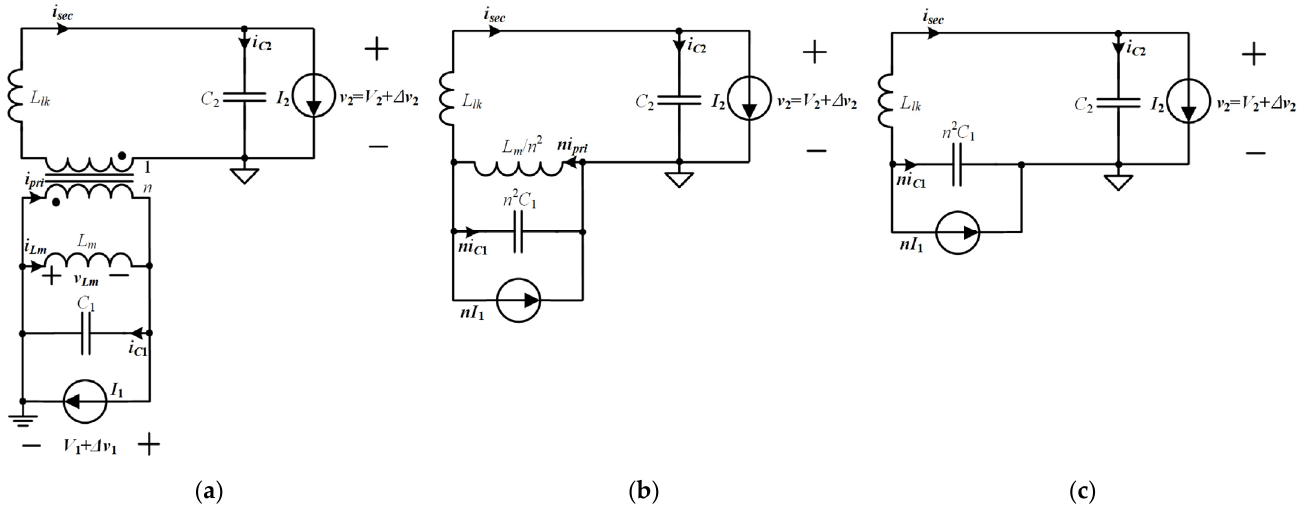
Figure 4. Equivalent circuit of the fly-buck converter in flyback mode: ( a ) Basic equivalent circuit; ( b ) Equivalent circuit when the primary side is reflected to the secondary side; ( c ) Equivalent circuit when L m is large enough.